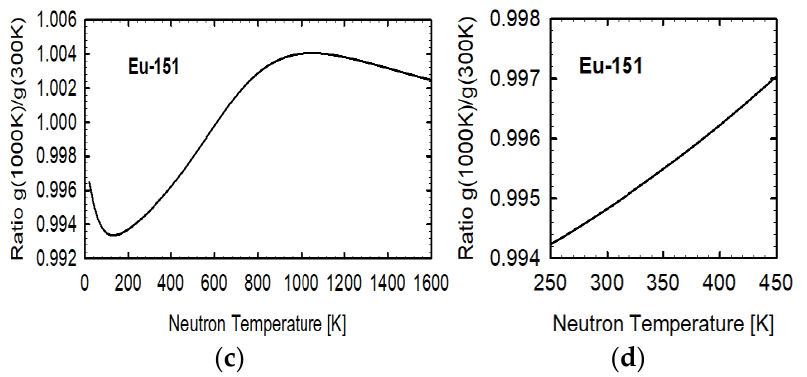
Figure 5. ( a ) Westcott g-factor for 151 Eu as a function of neutron temperature 𝑇 𝑛 , for two sample temperatures, 𝑇 𝑠 = 300 K(black) and 1000 K (red); ( b ) Expanded figure of (a); ( c ) Ratio of Westcott g-factor for 𝑇 𝑠 = 1000 K to that for 300 K; ( d ) Expanded figure of (c).